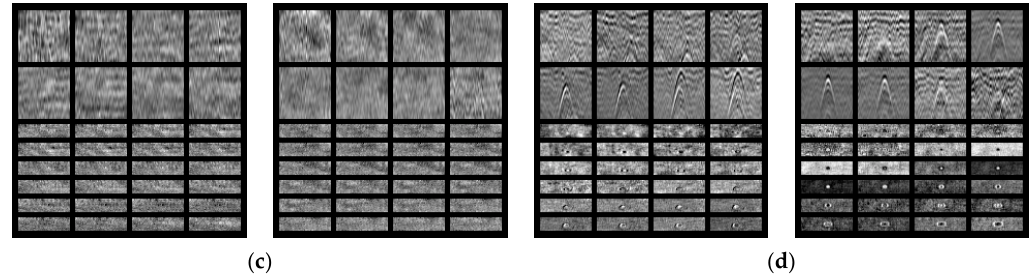
Figure 11. The representative testing images of ( a ) cavities, ( b ) manholes, ( c ) subsoil backgrounds, and ( d ) gravels.